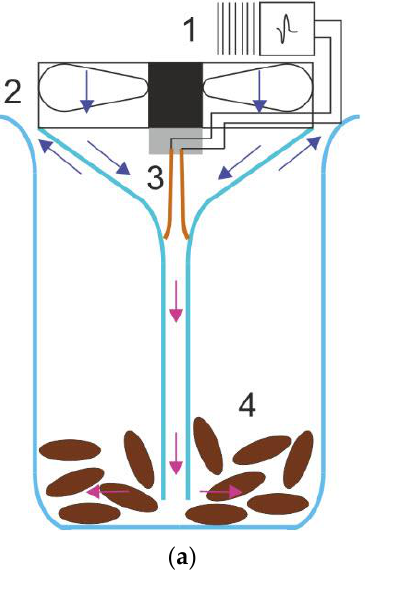
Figure 1. Experimental setup for CAP treatment: 1—high voltage pulse generator; 2—fan; 3—glass funnel with DBD source; 4—glass beaker with a sample ( a ). Circuit diagram of a high voltage pulse generator prototype used in the experiment ( b ).